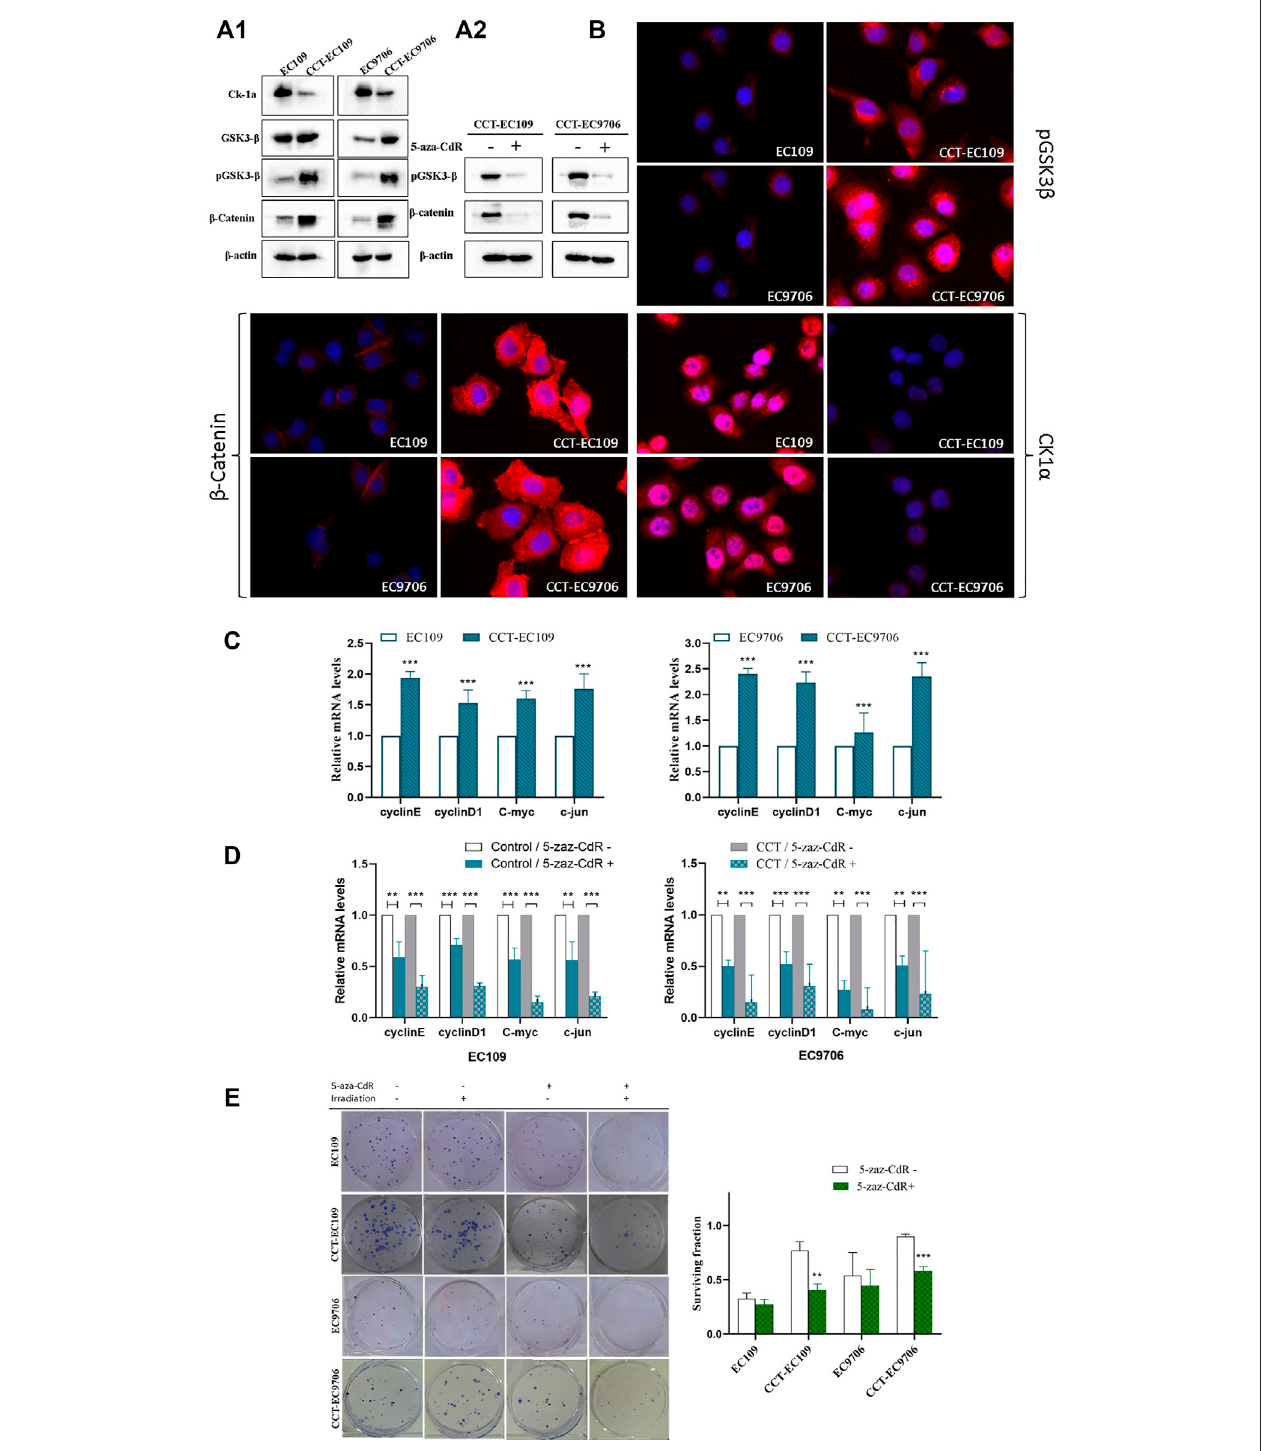
FIGURE 6 | Western blot analysis on the expression of CK1 α , GSK3 β , p-GSK3 β and β -catenin in CCT-ESCC and their parental cells (A1) , and with or without 5- aza-CdR treatment in CCT-ESCC cells (A2) . and immuno fl uorescence staining of p-GSK3 β , β -catenin and CK1 α in the exposed and control cells (40×) (B) . qRT-PCR results for relative transcript levels of Wnt signaling pathway target genes in CCT-ESCC cells and control cells (C) . and with or without 5-aza-CdR treatment in CCT- ESCC cells and the controls (D) . Gross view of colony formation (left panel) and corresponding quantitative analyses of the relative surviving fraction in CCT-ESCC cellsandcontrolcells (E) . β -actinwasusedasthehousekeepinggeneandrawdatawasanalyzedbythe2 − ΔΔ Ct method.Thesurvivingfractionwascalculatedasfollows (numberofcolonies/number ofcellsplated) irradiated /(number ofcolonies/number ofcells plated) nonirradiated . Datarepresentmean ±SD ofthree independent experiments. * p < 0.05; ** p < 0.01; *** p < 0.001.